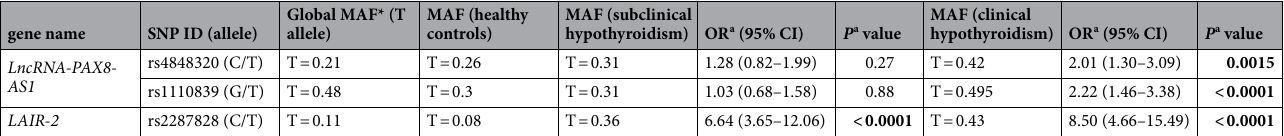
(Table 2). In clinical hypothyroid patients, the rs4848320 and rs1110839 log-additive models were significant and showed a noticeable clinical hypothyroid risk (adjusted OR = 2.26 and 2.55, respectively, P < 0.0001). In addition, among the subclinical hypothyroid patients, the genotype distribution and allele frequencies of rs4848320 and rs1110839 did not show a statistically significant difference when compared with those in the healthy controls ( P > 0.05) (Table 3). Interestingly, the minor T allele frequency of LAIR-2 rs2287828 (C/T) was associated with 8.50 and 6.64-fold increase in the risk of clinical and subclinical hypothyroidism, respectively (T vs. C allele, P < 0.0001 for each) as shown in Table 2. Moreover, a markedly high risk for clinical and subclinical hypothyroidism was also depicted from the rs2287828 dominant (CT + TT vs CC) model (Adjusted OR = 14.51 and 8.7, respectively, P < 0.0001) (Table 3). Like the other two SNPs, all results were adjusted for age and sex as covariates.